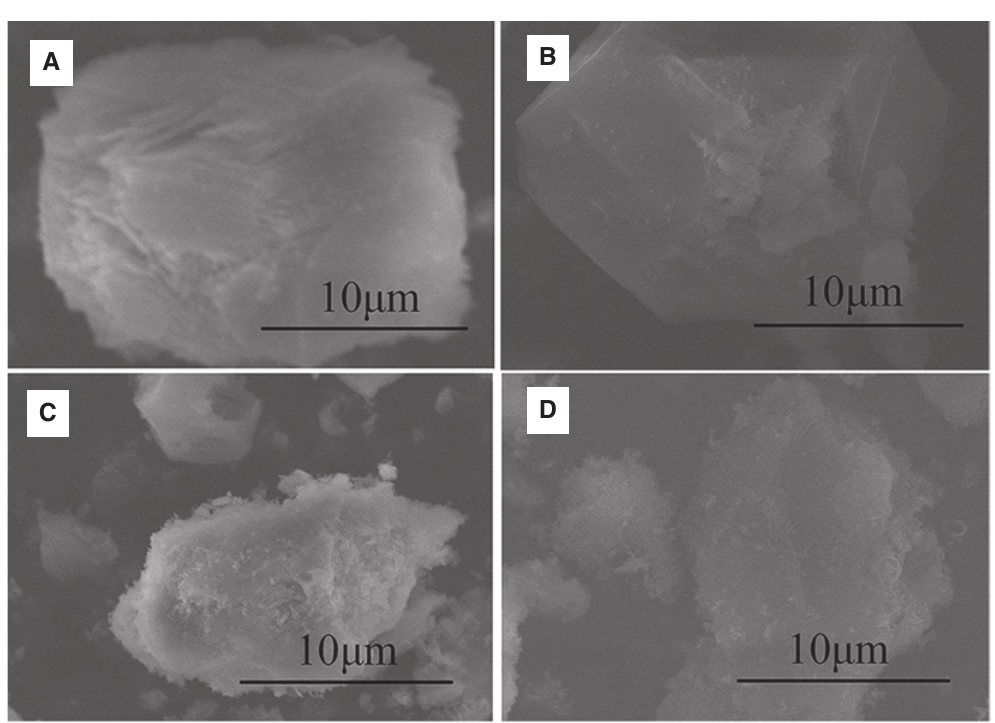
Figure 2: SEM images of the pyrolysis products (A) 700 ° C, (B) 800 ° C, (C) 900 ° C, (D) 1000 °